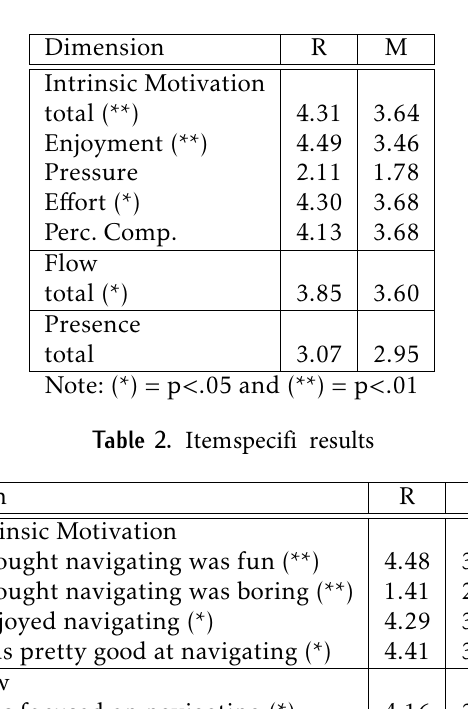
Figure 5. Poster forrecruitingparticipantsfromlocal schools. counterbalanced with the purpose of reducing the environmental e ff ects met on the route on the results. Participants would either begin with map or riddles, and would end with the navigational method di ff